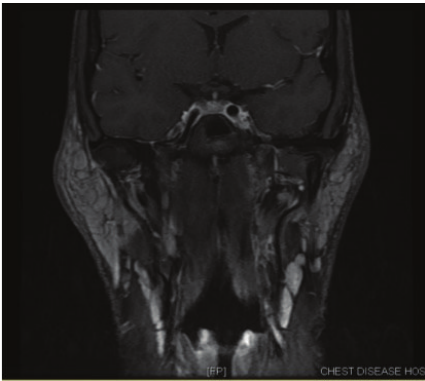
Figure 1: Preoperative MRI T1-weighted coronal cut: bilateral enlarged parotids and intraglandular lymph nodes.